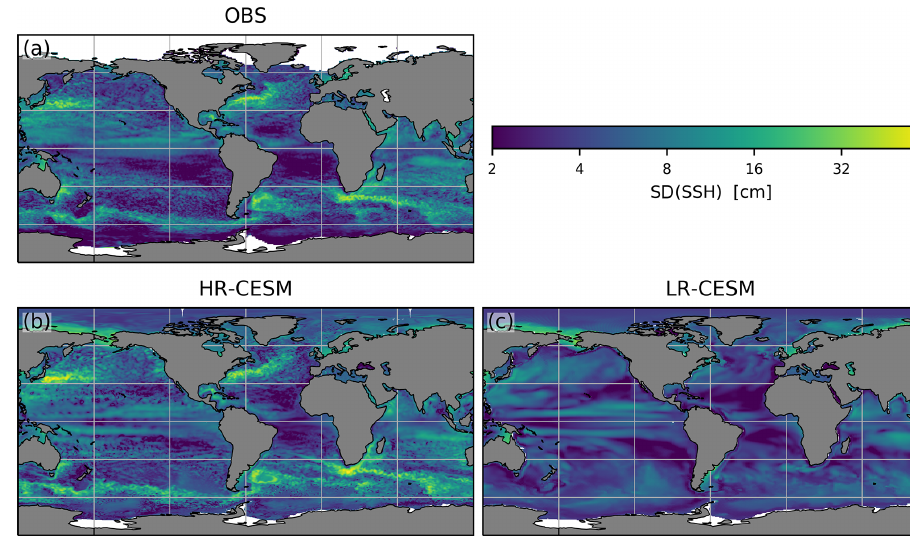
Figure A4. The standard deviation of the observed sea surface height (a) and the modeled dynamic sea level (b, c) , like Fig. 4.